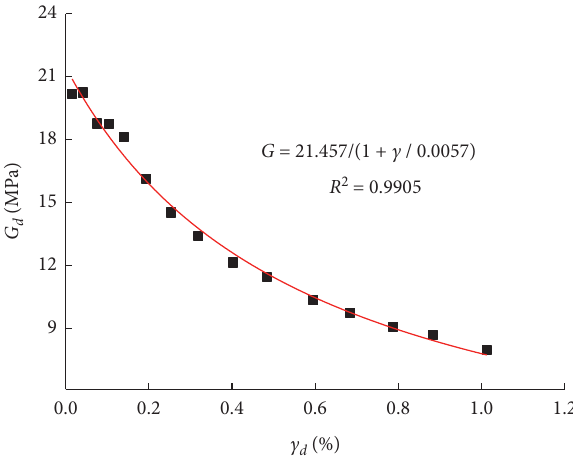
Figure 8: Typical dynamic shear modulus-shear strain curve fitting